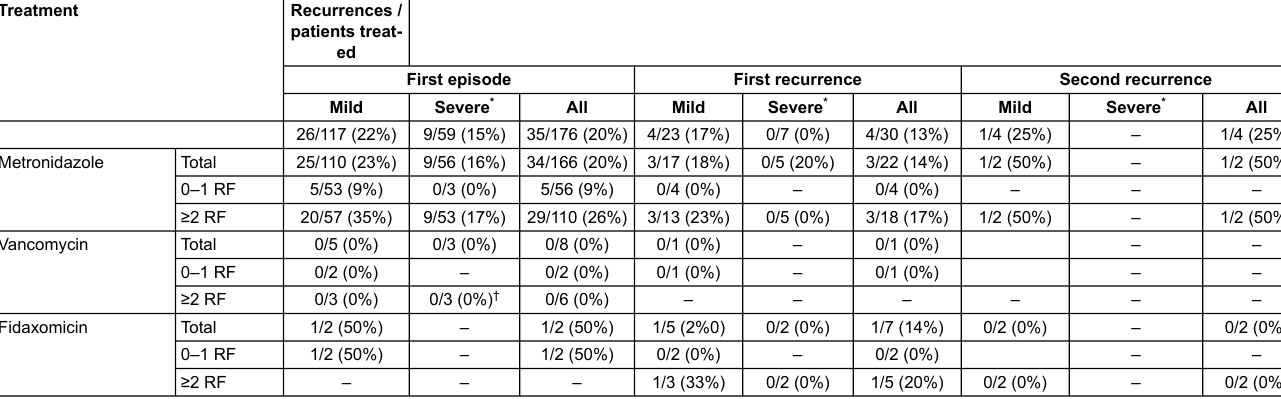
Table 3: Outcome according to Clostridioides difficile infection treatment by episode/recurrence, risk factors for recurrence and severity of disease.